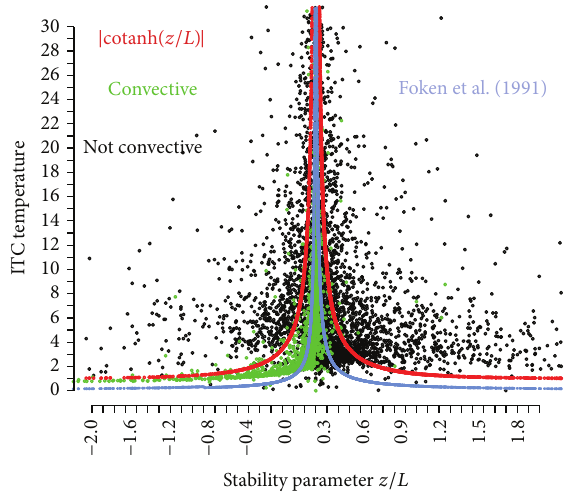
Figure 8: Absolute values of the temperature ITC’s (calculated following formulas (2) and (3)) for the convective period (16.6.– 31.8., green dots) and the rest of the shown year (1.9.–15.6., not convective, black dots) in dependency of the stability parameter 𝑧/𝐿 . Additionally shown are the absolute values of the hyperbolic cotangent of the values of 𝑧/𝐿 (red dots) and the temperature ITC’s following the parameterisation of Foken et al. ([27], blue